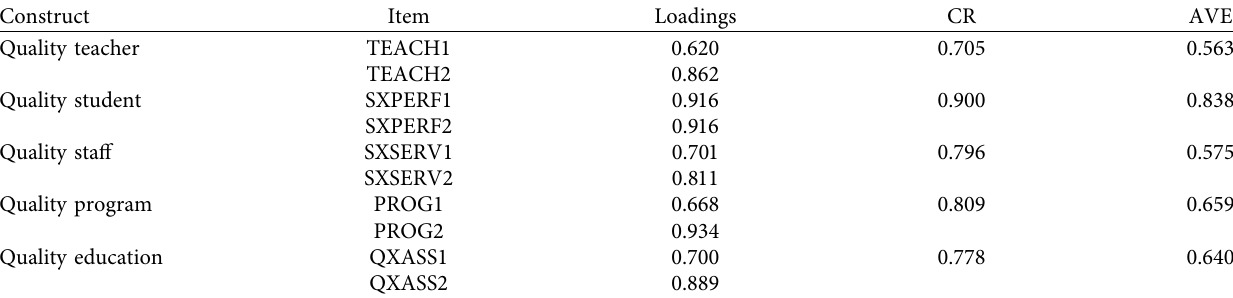
Table 2: Measurement model evaluation.